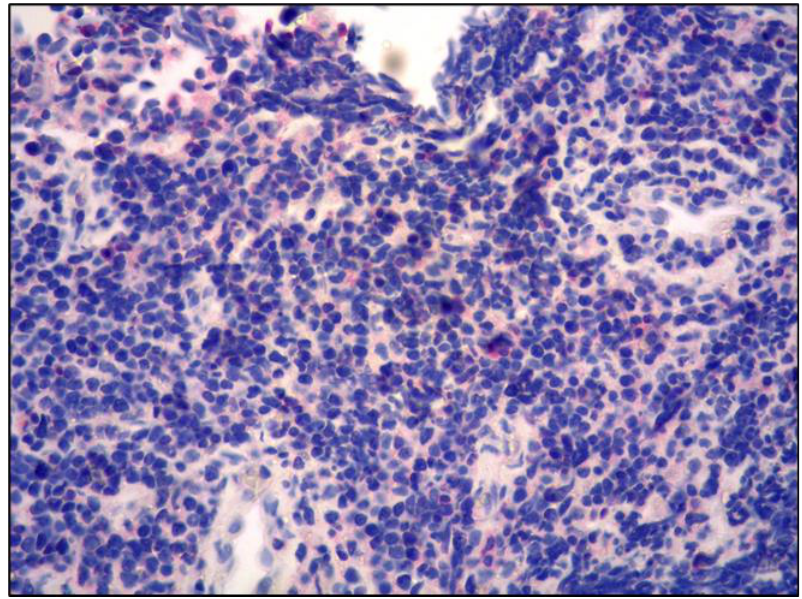
Figure 4. CD5 negativity of the lymphoid proliferation (CD5 immunostaining; 200× magnification; original image from Prof. S.A.).